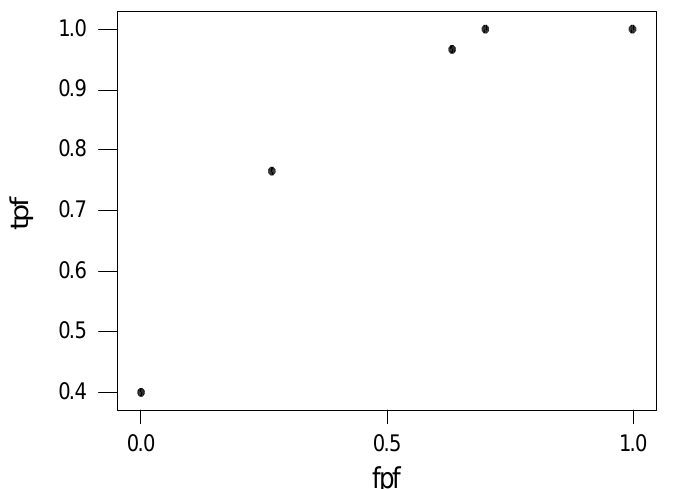
Figure 2. Empirical ROC for